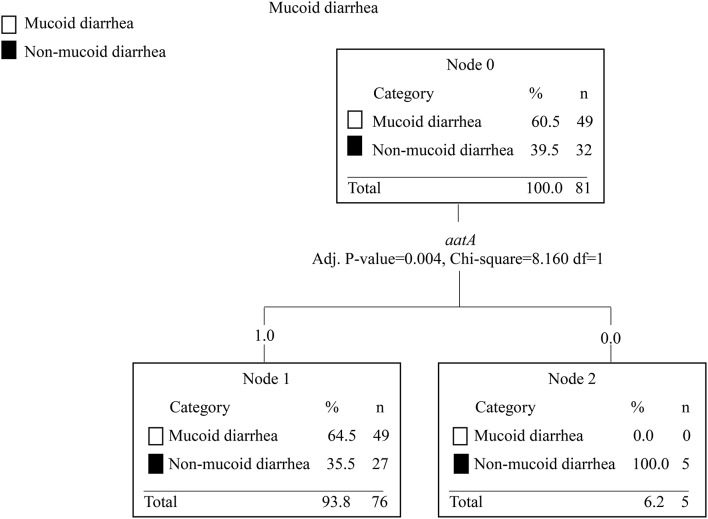
The CART tree analysis shows the association between EAEC genes and mucoid diarrhea. N is the number of children. The number 0 in each branch indicates the absence of a gene and the number 1 indicates the presence of a gene. EAEC genes included in the analysis were sat, sepA, pic, sigA, pet, astA, aap, aggR, aaiC, aatA, ORF3, agg3/4C, agg3A, aafA, aggA, agg4A, and agg5. Each branch in the CART tree terminates in a “node,” which represents a specific set of genes or absence of genes, which are statistically significant in the categories investigated. Strains lacking the aatA gene were associated with non-mucoid diarrhea, p = 0.004. No association between EAEC genes and watery or bloody diarrhea was observed.